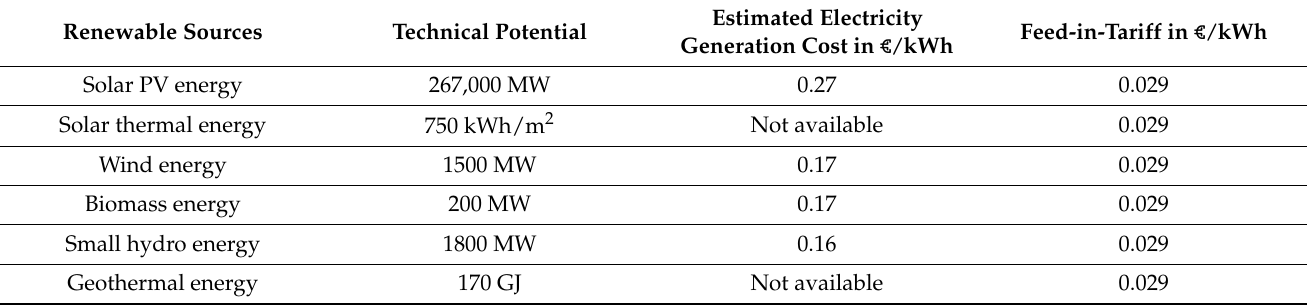
Table 3. Potential and estimated generation cost of energy by renewable energy source (data according to